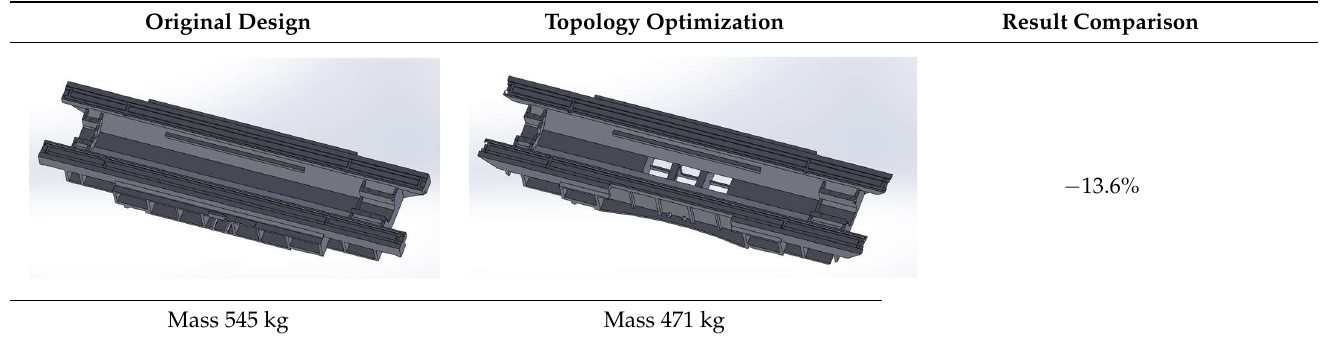
Table 13. Saddle-optimization result comparison.